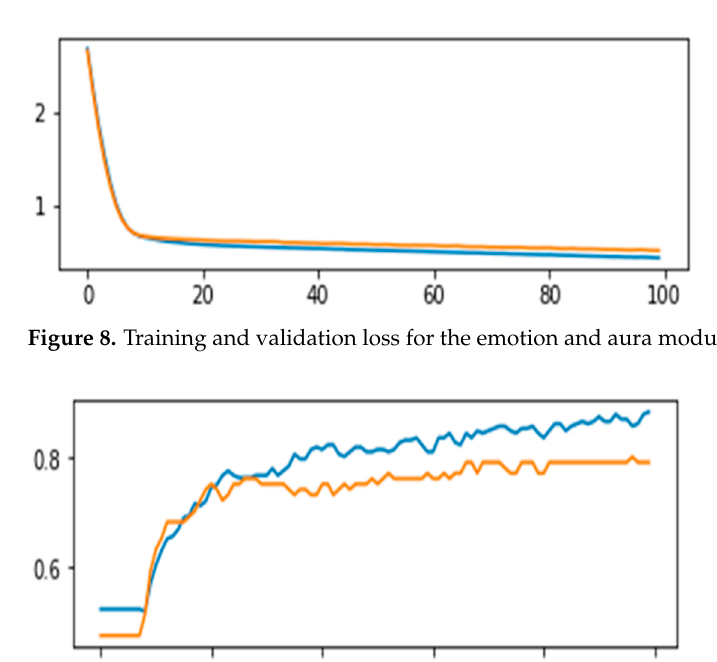
Figure 10. Comparative analysis of the modules.